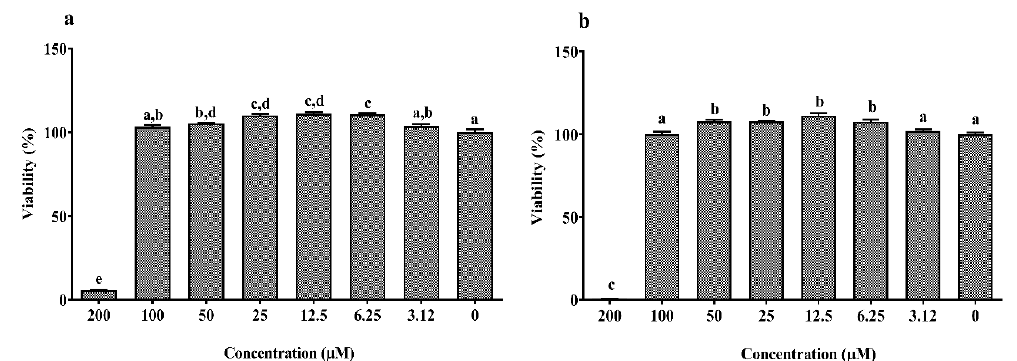
Figure 1. Dose–response effect of ( a ) eicosapentaenoic acid (EPA) and ( b ) docosahexaenoic acid (DHA) with different concentrations (0–200 μ M) on the Intestinal Porcine Epithelial Cell line (IPEC-J2) viability for 24 h. Data are presented as mean ± SEM ( n = 3, one-way ANOVA). Statistically significant differences among the treatments are denoted by different letters (a, b, c, d, e), where p < 0.05.